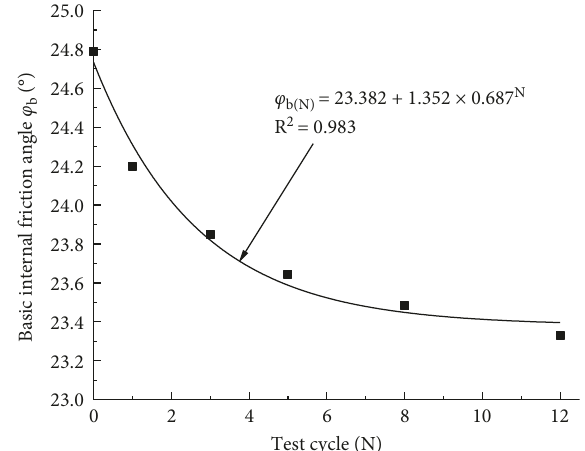
Figure 13: Deterioration curve of basic internal friction angles under heat-wet